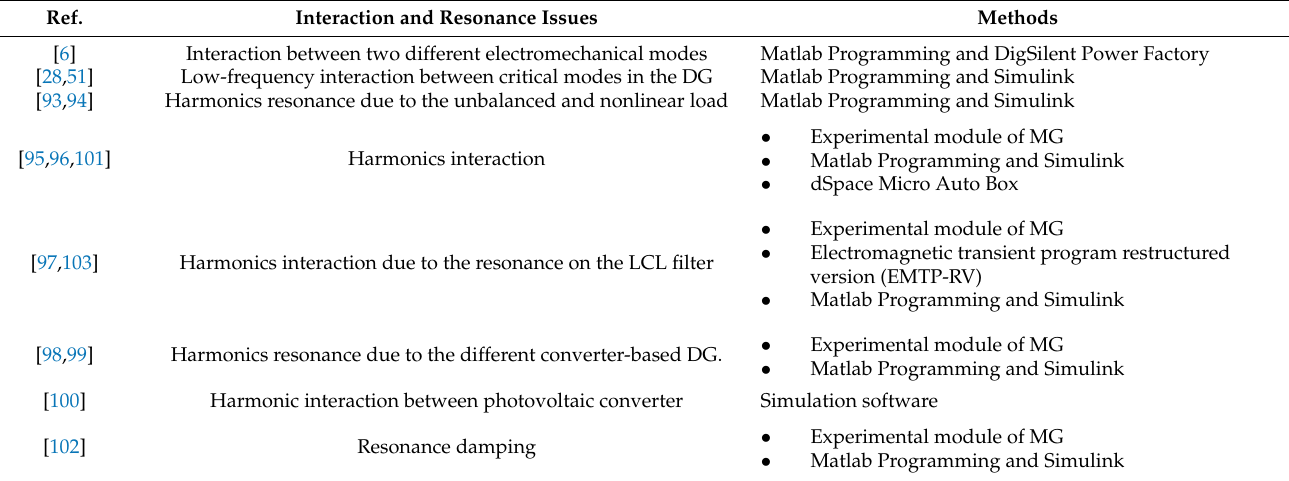
Table 4. Overview of interaction in